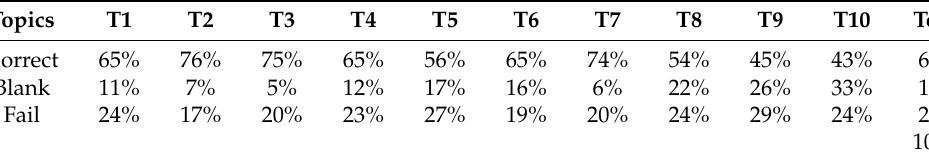
Table 7. Summary of results year 2019–2020.